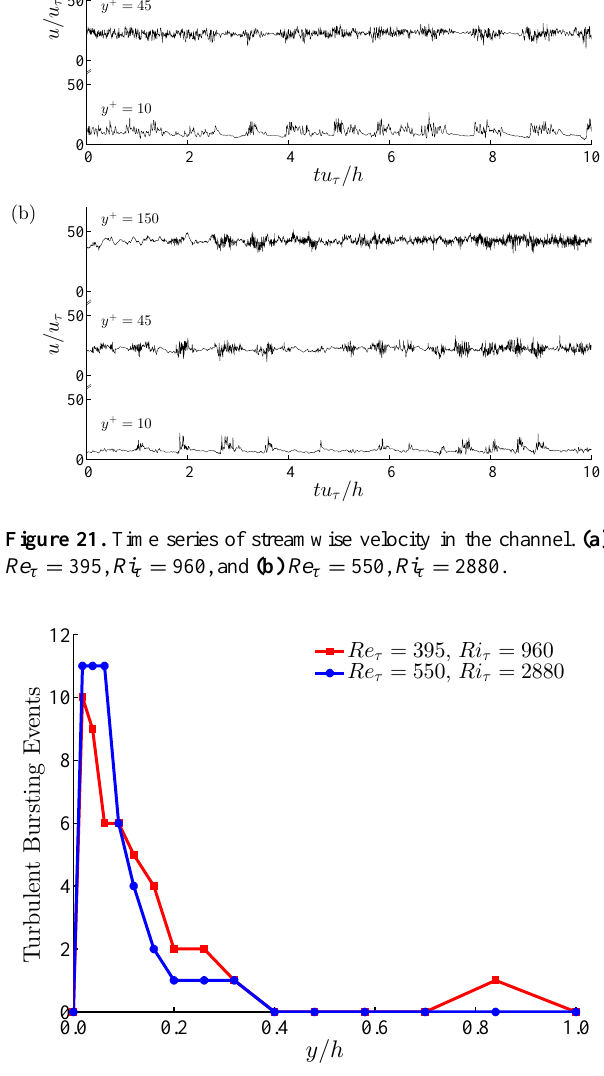
Figure 22. Vertical distribution of turbulent bursting events in the channel. The turbulent bursting events are calculated within 10 non- dimensional time.